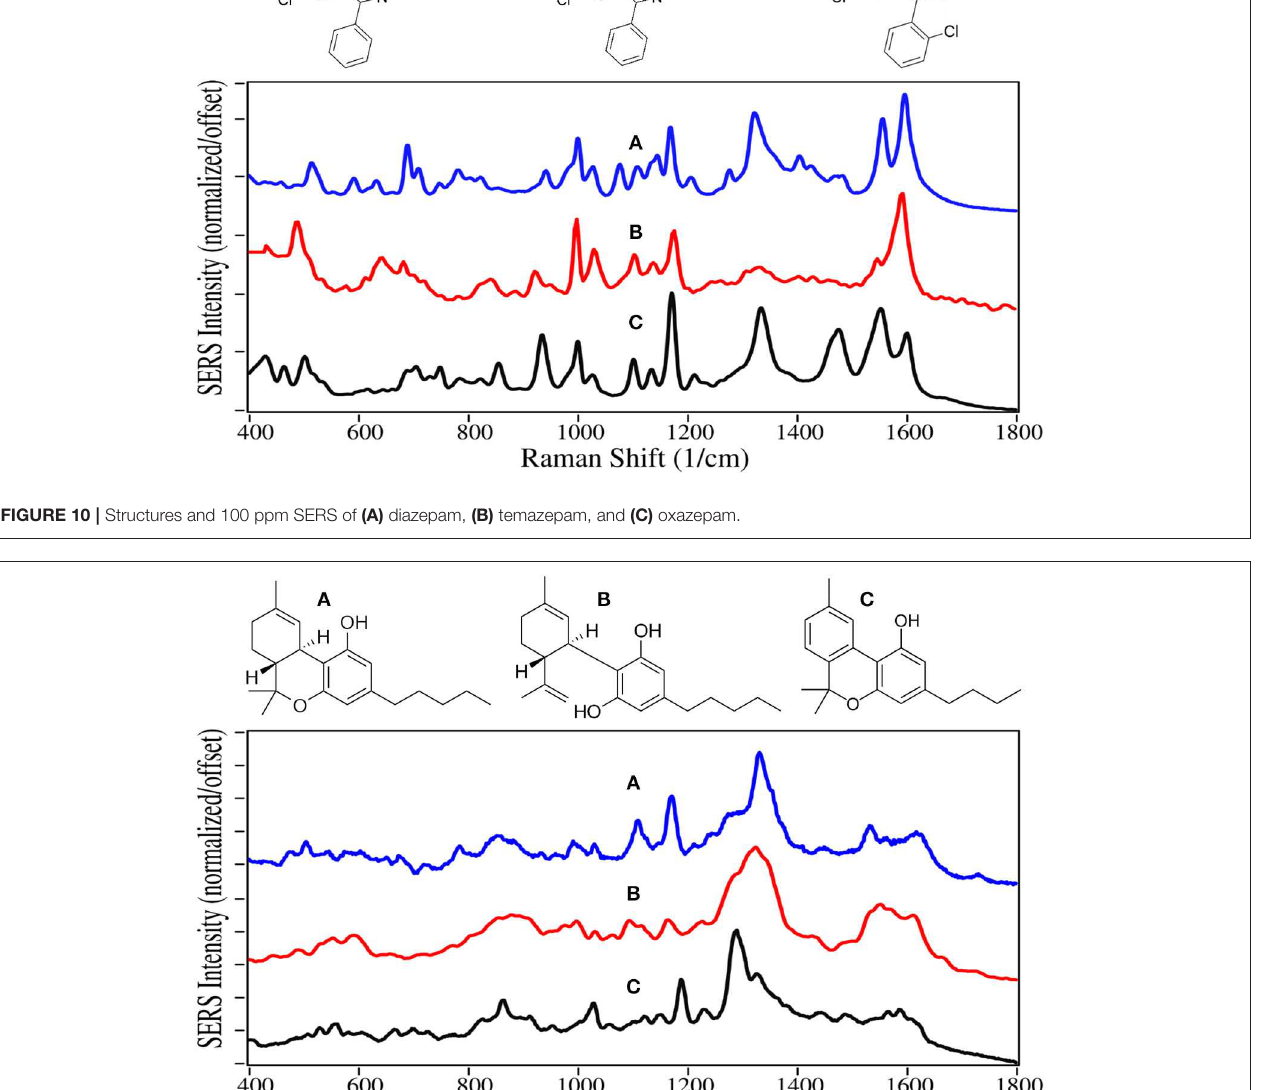
Frontiers in Chemistry |